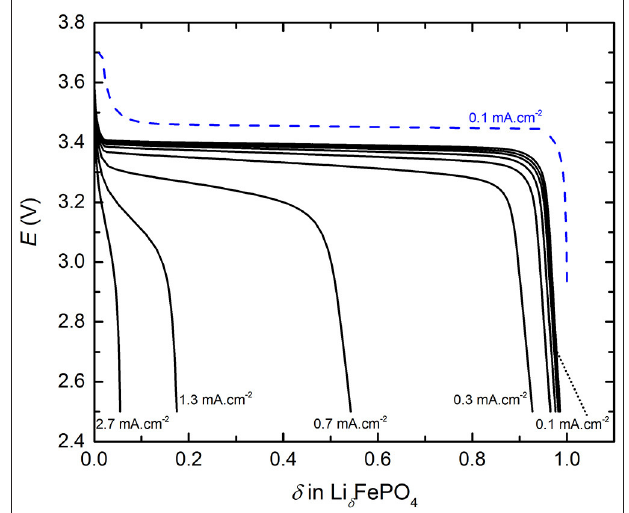
FIGURE 1 | Typical cycling profiles, potential E as a function of the fraction δ of Li inserted in Li δ FePO 4 , of the conventional power test for a LMP(48-18) battery. The dashed blue curve is the charge